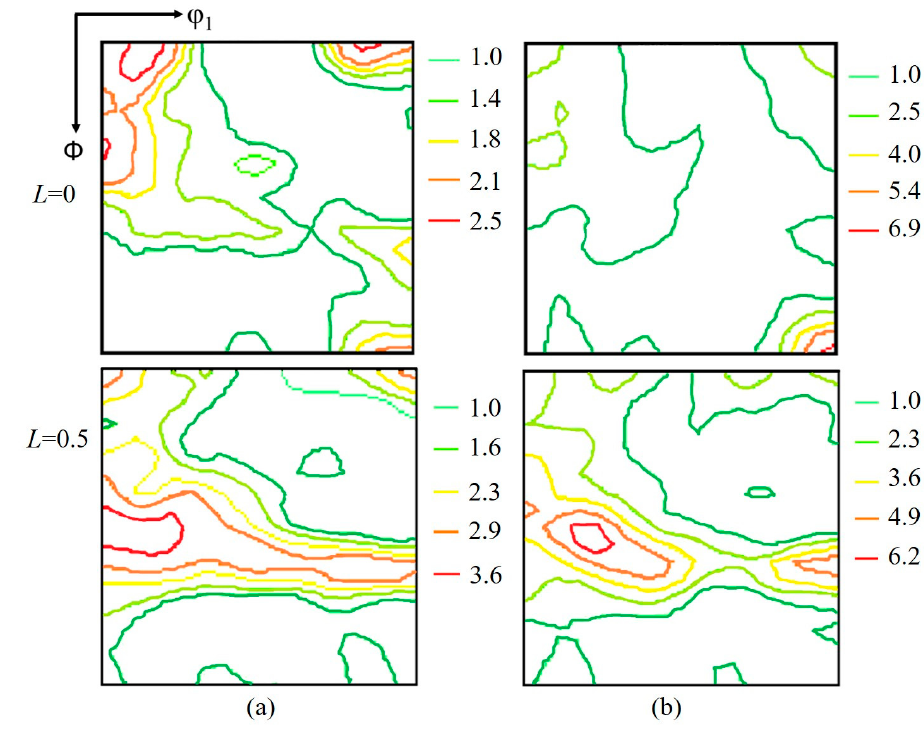
Figure 2. Constant φ 2 = 45° section of orientation distribution functions (ODFs) at surface ( L = 0) and middle layer ( L = 0.5) in warm rolled sheets: ( a ) 0Cu; and ( b ) 0.5Cu.